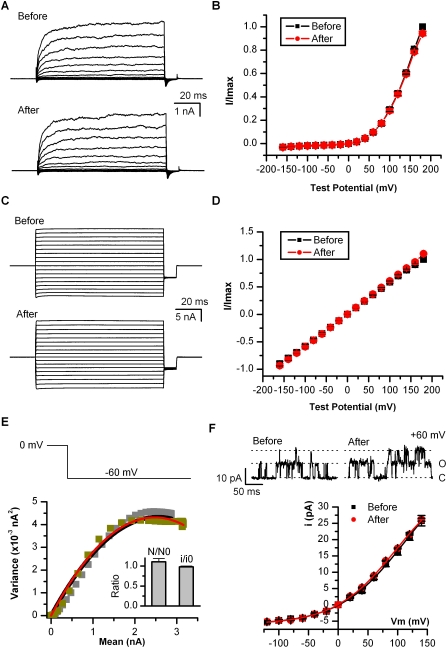
Retention of Normal Gating after Desensitization(A) Whole-cell currents evoked by voltage in the absence of agonist before (top) and after (bottom) desensitization. Currents were elicited with 100-ms test pulses ranging from −160 to +180 mV in 20-mV increments within the same cells. V
h = −60 mV. Before test pulses, the membrane potential was briefly depolarized to 0 mV for 20 ms. Full desensitization was ensured by prolonged application of 1 μM capsaicin plus 1.8 mM Ca2+.(B) Current-voltage relations for data in (A). V
1/2 = 145 ± 2 mV before and 152 ± 2 mV after desensitization (n = 12).(C–D) Voltage-dependence of saturating capsaicin responses before (top) and after (bottom) desensitization. Test voltage protocols were the same as in (A). Capsaicin concentrations were 1 μM before desensitization and 100 μM afterwards. I-V relations were averaged from six patches.(E) Fluctuation analysis for estimation of the number of channels and the unitary current. Nonstationary currents were evoked by stepping voltage from 0 to −60 mV (top) for ∼200 repetitions. Plotted are the resultant variances as functions of mean currents along with their parabolic fittings (gray/black, before; dark yellow/red, after). The inset shows the relative changes in the number of channels and the unitary current (N/N0 = 1.1 ± 0.1, i/i0 = 0.98 ± 0.02, n = 5). Because the opening with voltage alone was relatively low, a low dose of capsaicin was applied to ensure appropriate Po as well as an adequate number of samples containing intermediate currents on the rising phase of activation (0.3 μM before and 10 μM after desensitization).(F) Direct measurement of unitary current. Top: exemplar recordings from outside-out patches excised before and after desensitization (different cells). Bottom: voltage-dependence of the unitary current (n = 4–6). Experiments in the figure were performed in Ca2+-free bath solutions.